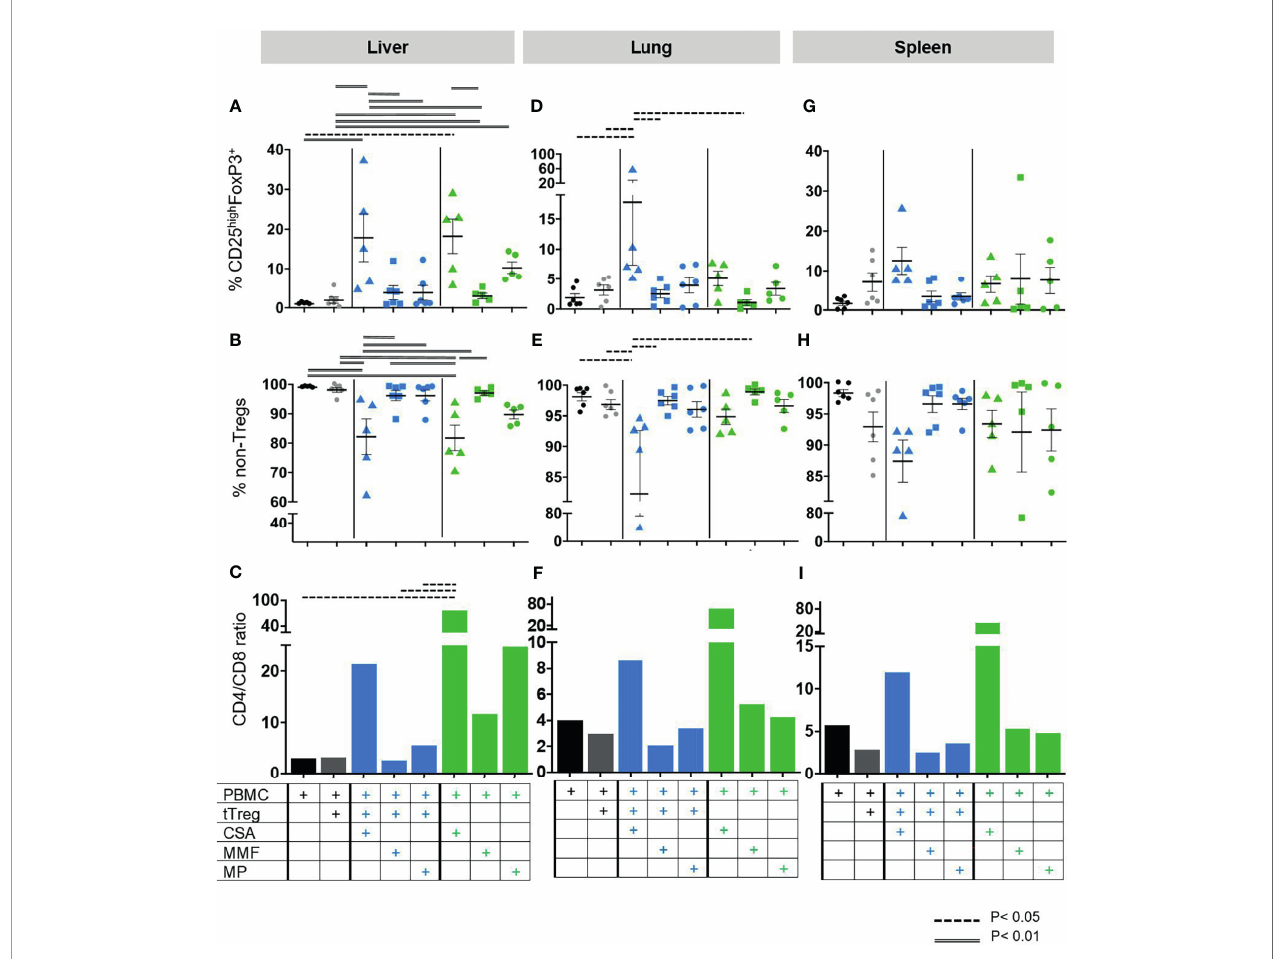
FIGURE 5 | Composition of lymphocytic organ in fi ltrates. As described in Figure 1 GvHD was induced by 3x10 6 human PBMCs in NOD/SCID/IL2Rgamma-/- mice. Mice were subsequently treated with (i) the cISD (green symbols) CSA (4 mg/kg s.c., triangles), MMF (0.5 mg p.o, squares) or MP (20 mg/kg i.p., dots) (n=5) alone (n=5), (ii) with ex vivo expanded tTregs at a PBMC:tTreg ratio of 2:1 (n=6, grey dots), or (iii) with a combination of cISD and low dose tTregs (PBMC:tTreg ratio 2:1; CSA/tTreg n=5; MMF/tTreg, n=6; MP/tTreg n=6, blue symbols). Organ samples from liver, lung and spleen were further analyzed by fl ow cytometry to assess lymphocytic in fi ltration and proliferation. All samples were analyzed directly after harvesting as outlined in Table 1 . To this end human live lymphocytes were identi fi ed as human CD45+ cells and subsequently gated as CD3+ cells. CD3+ T-lymphocytes were subdivided into CD4+ and CD4- cells. Treg cells were identi fi ed as CD25highFoxP3+ cells within the CD4+ compartment (A, D, G) , while the remaining CD4+ cells were considered as non-Treg CD4+ T-cells (B, E, H), CD8 + T-cells were identi fi ed as CD3 + CD4 - . Subsequently CD4/CD8 ratios were analyzed for each group. (C, F, I) . Depicted are individual values and mean values ± SEM. Statistical analysis was performed as One-Way-ANOVA with Tukey correction for multiple comparisons. Statistical signi fi cance levels are indicated as p < 0.05 (dashed line), p < 0.01 (doubled line), p < 0.001 (solid line). CSA, Cyclosporine A; MMF, Mycophenolate Mofetil; MP,